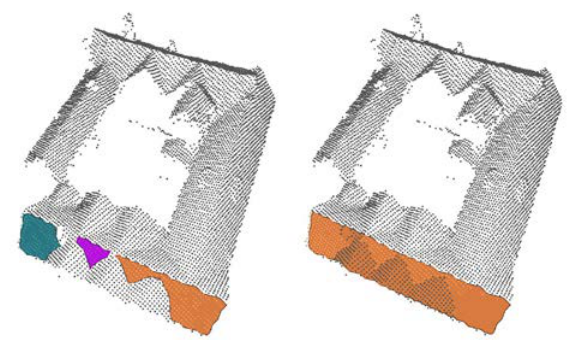
Figure 2. Segmentation of planar regions as a result of surface growing (left) and sub-surface growing